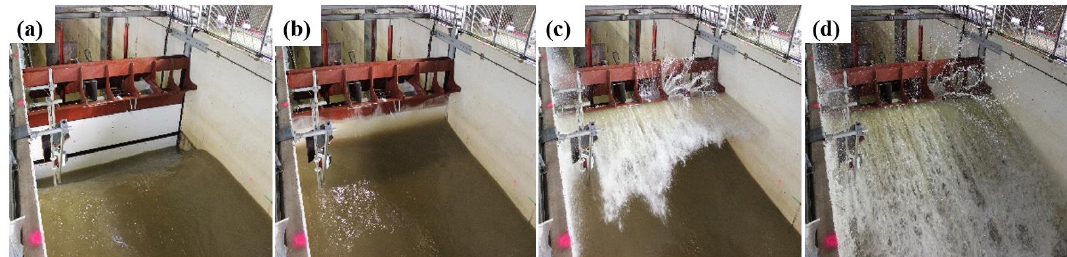
Figure 2. Sequence of snap-shots (from a – d ) from the present experiments showing a wave approaching and interacting with a vertical seawall with a recurve on top.